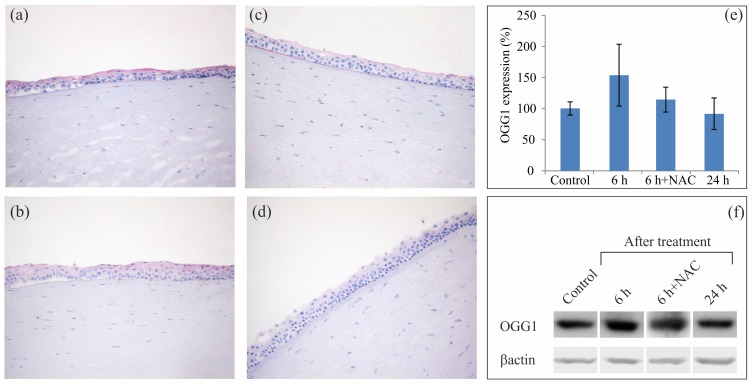
Detection of OGG1 in human corneas treated ex-vivo with APCP.Corneal tissues exposed for 2 min to APCP were analyzed by immunohistochemistry (a-d) and Western Blot (e-f). Frozen sections (5 μm) of corneas treated in the absence (a) or presence (b) of 10 mM NAC were incubated with polyclonal rabbit anti-OGG1 at 6 h post-treatment. Protein immunostaining (in red) was compared to that of untreated controls (c). Negative controls were prepared by omitting the primary antibody (d). For the Western Blot analysis, proteins were extracted at 6 and 24 h post-treatment: the OGG1 protein signal increased at 6 h, and was reduced in the presence of NAC, and returned to values comparable to that of controls within 24 h. Densitometric values of OGG1 autoradiographic bands were normalized to corresponding β-actin and expressed as percentage ± SE of the mean control value.